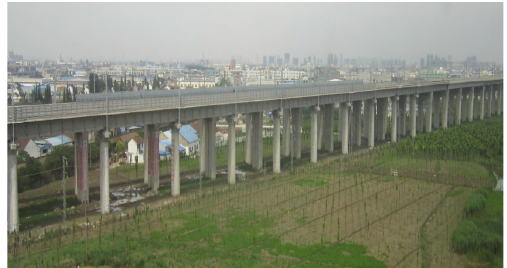
Figure 2: Cutting scenario.